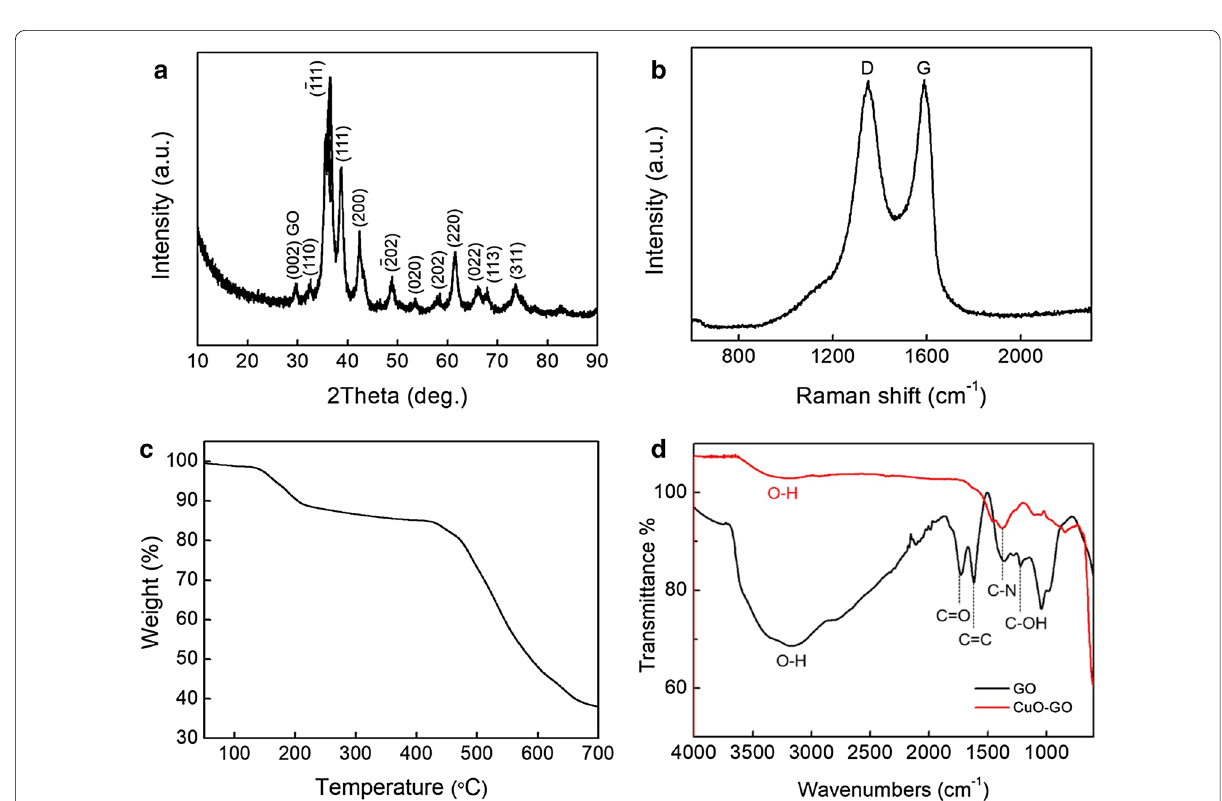
Fig. 2 a XRD diffraction pattern, b Raman spectrum, c TGA analysis, and d FT‑IR spectrum of the CuO–GO nanocomposite